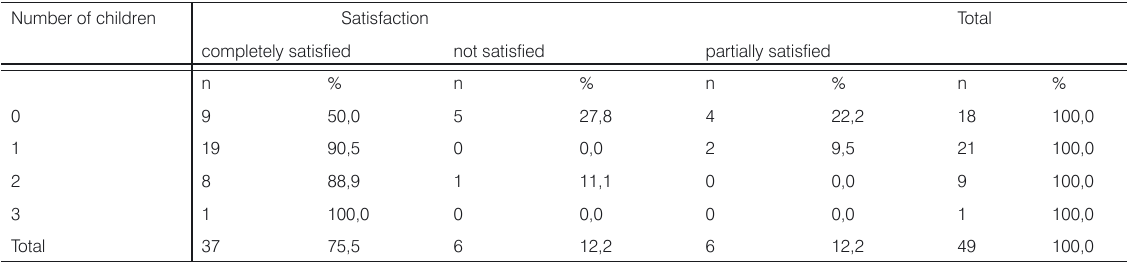
Table 2. Dependency between the number of children and satisfaction with the results of operation p<0,005.